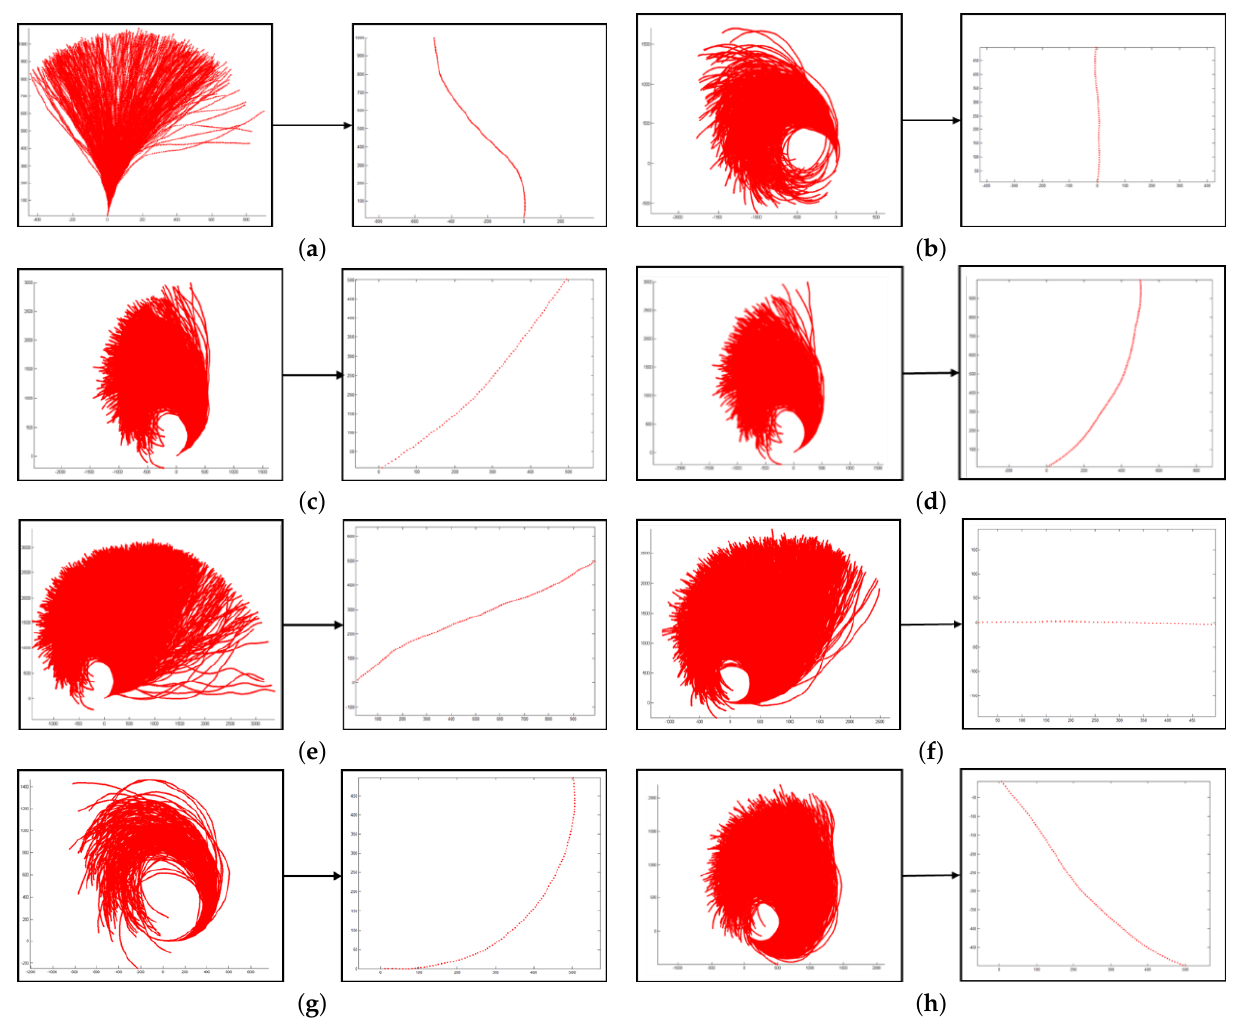
Figure A1. Regularization-trajectory cell library: the first section. ( a ) Regularization-trajectory cells from the initial 0 ◦ direction to 45° (rudder angle is 13.6°). ( b ) Time-varying trajectory cell from the initial 0 ◦ direction to 0 ◦ (rudder angle is − 1.92°). ( c ) From the initial 45 ◦ direction to the 45 ◦ regularization-trajectory cell (rudder angle is − 11.52°). ( d ) Time-varying trajectory cell from the initial 45 ◦ direction to 0 ◦ (rudder angle is − 13.66°). ( e ) Time-varying trajectory cell from the initial 45 ◦ direction to 90 ◦ (rudder angle is 2.58°). ( f ) Time-varying trajectory cell from the initial 90 ◦ direction to 90 ◦ (rudder angle is − 0.66°). ( g ) Time-varying trajectory cell from the initial 90 ◦ direction to 0 ◦ (rudder angle is − 11.52°). ( h ) From the initial 135 ◦ direction to the 135 ◦ regularization-trajectory cell (rudder angle is −